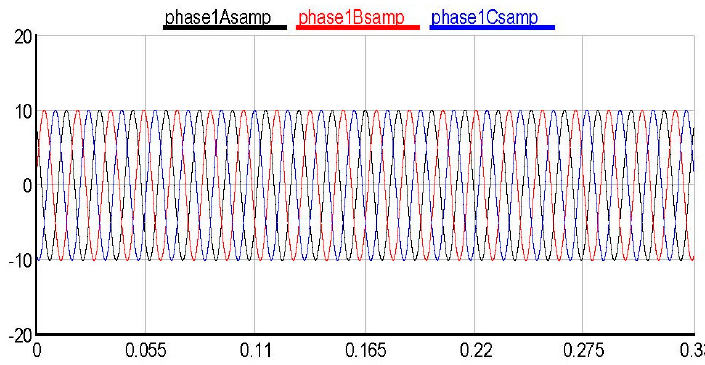
Figure 21. Current waveforms for pre-fault condition.